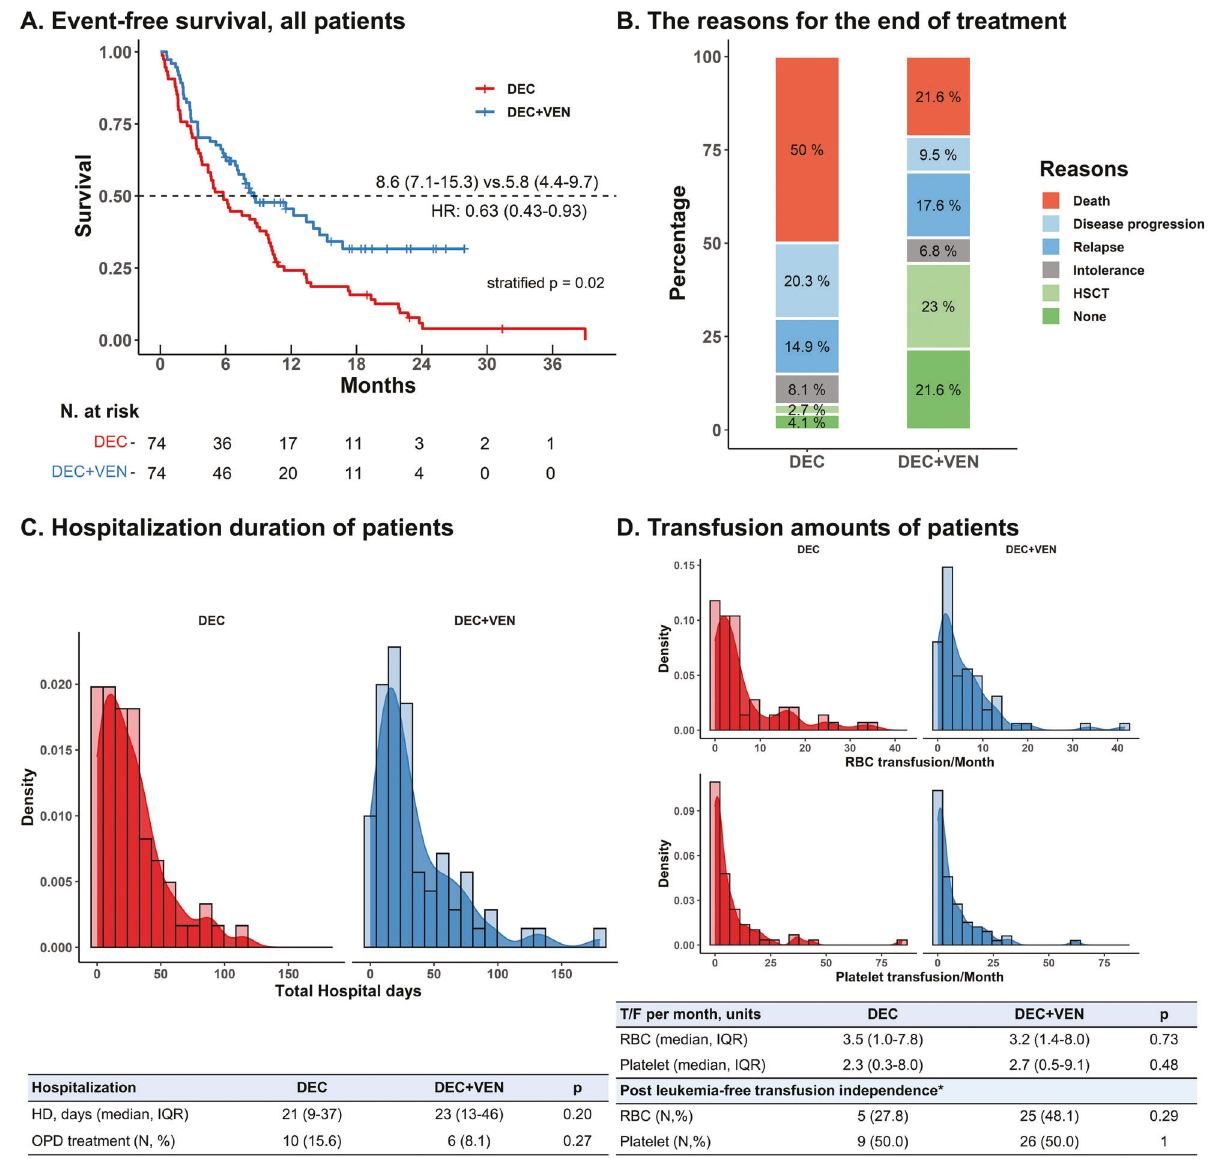
Fig. 2 Various treatment outcomes of patients. A Event-free survival of whole matched patients. B The reasons for the end of treatment in both treatment groups. C Hospitalization duration of patients. D RBC/platelet transfusion requirement of patients. *In patients who obtained a leukemia-free state. DEC decitabine, EFS event-free survival, F/U follow-up, HD hospitalization days, HR hazard ratio, HSCT hematopoietic stem cell transplantation, IQR interquartile range, OPD outpatient department, RBC red blood cell, T/F transfusion, VEN